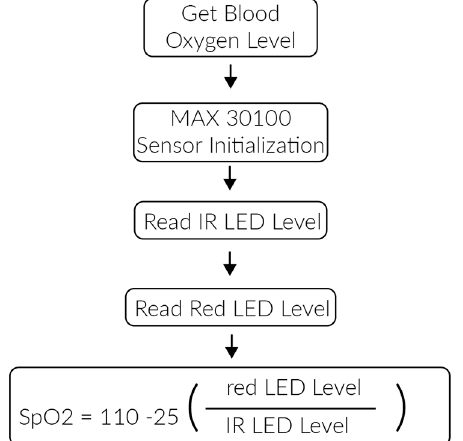
Figure 4. Blood oxygen monitoring algorithm.